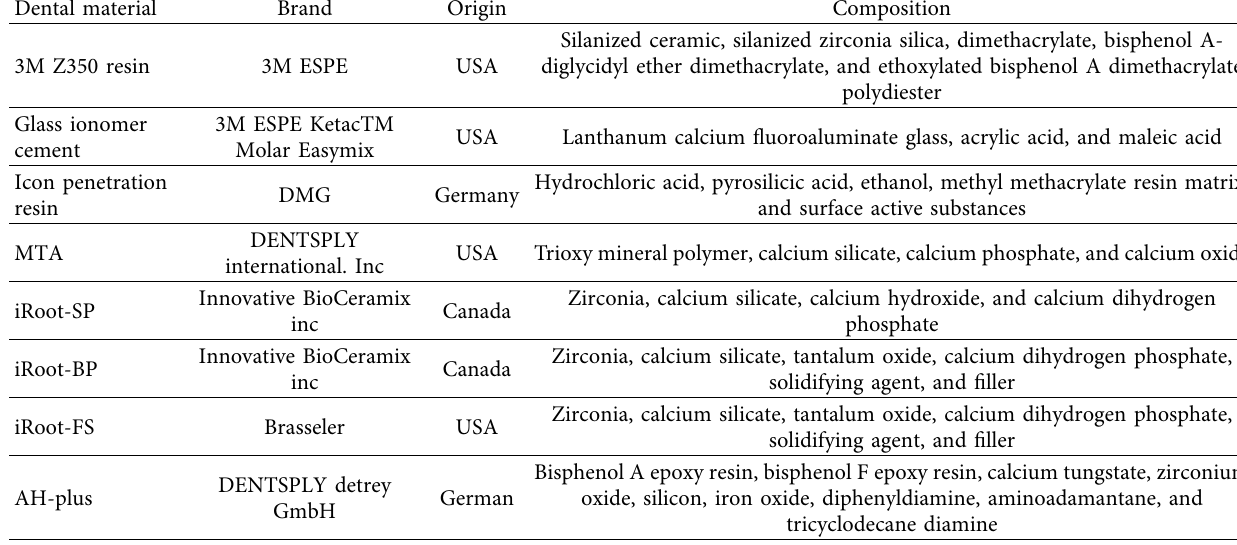
Table 1: The composition of the dental